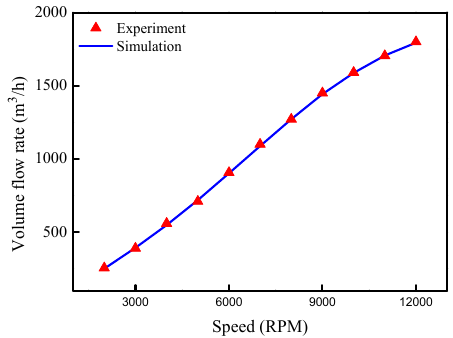
Figure 7. Volume flow rates of compressor in simulation and experiment.